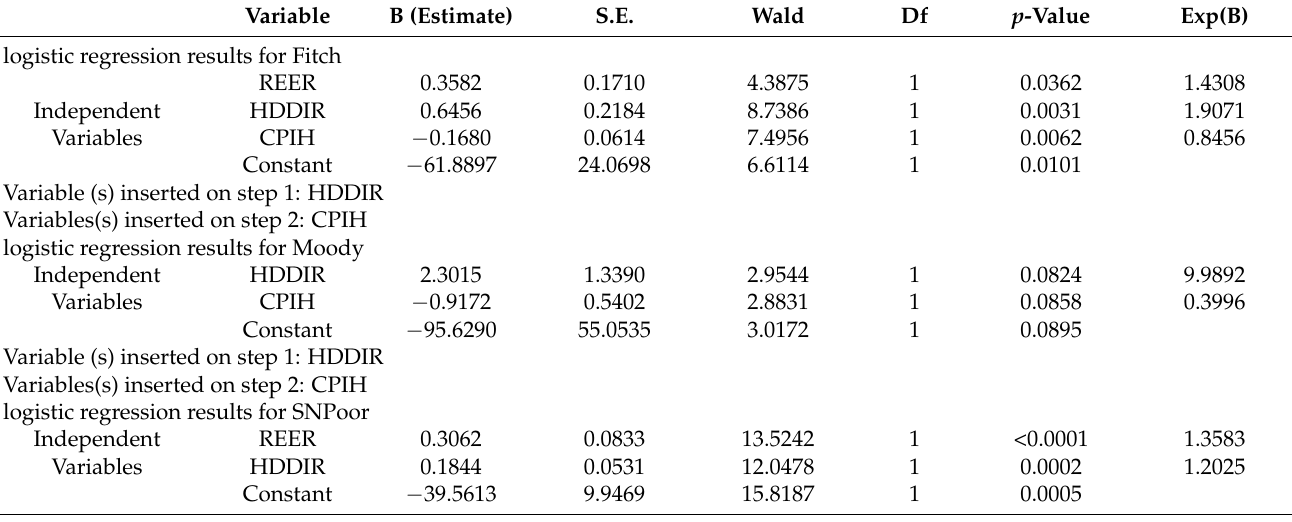
Table 6. Logistic Regression